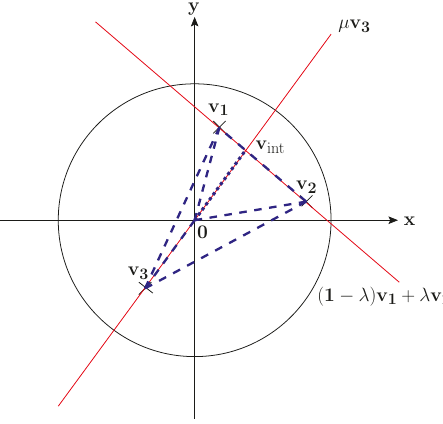
Figure 5 . Graphical illustration of three-point partial